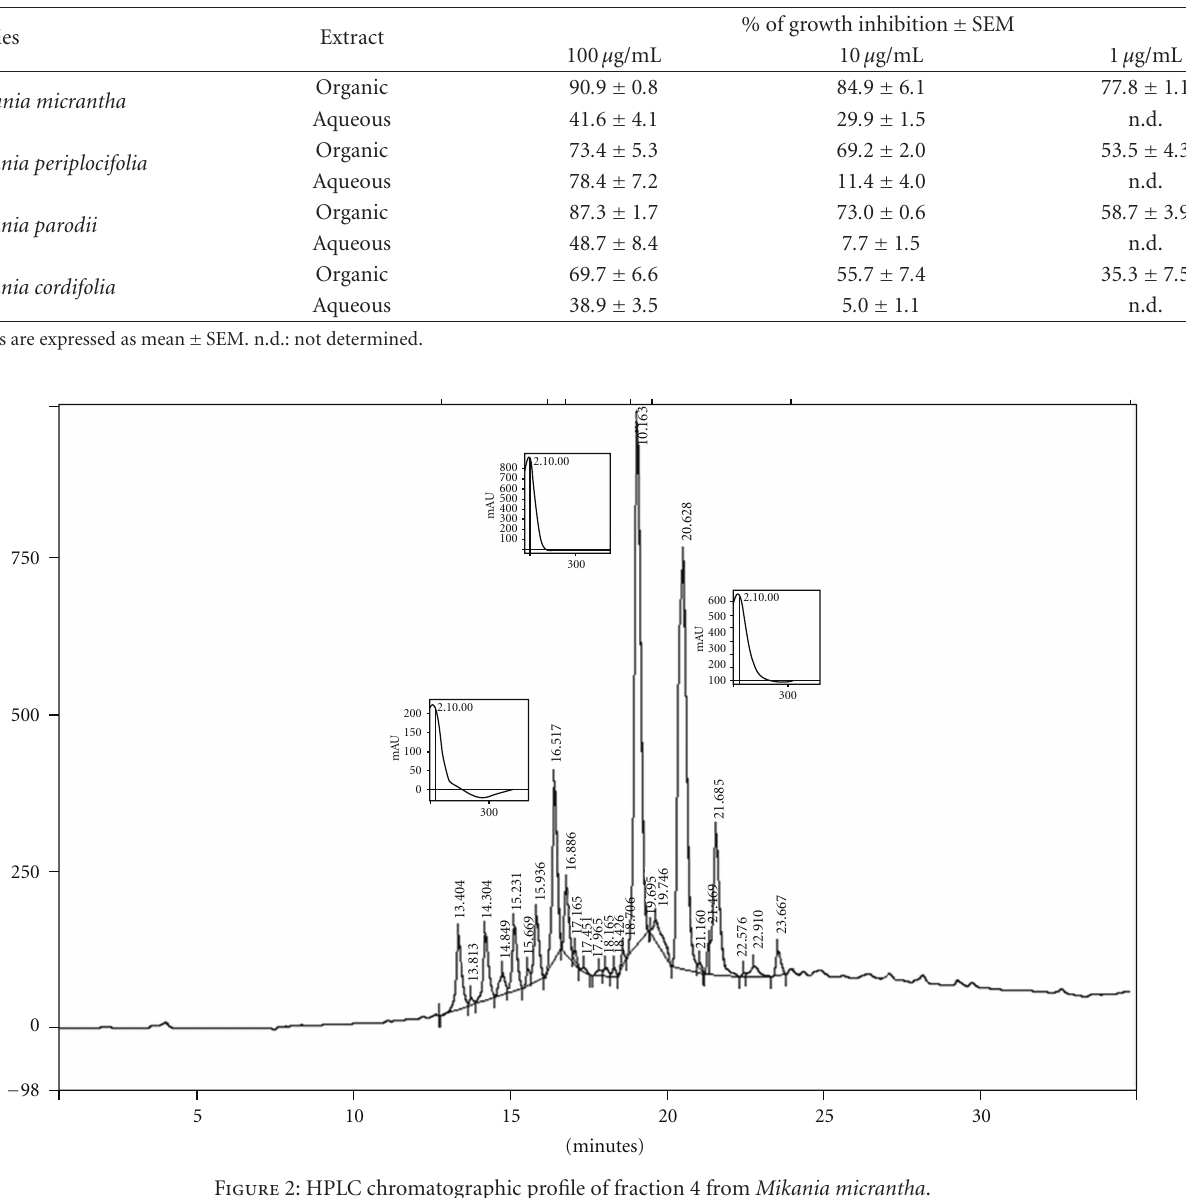
Figure 2: HPLC chromatographic profile of fraction 4 from Mikania micrantha